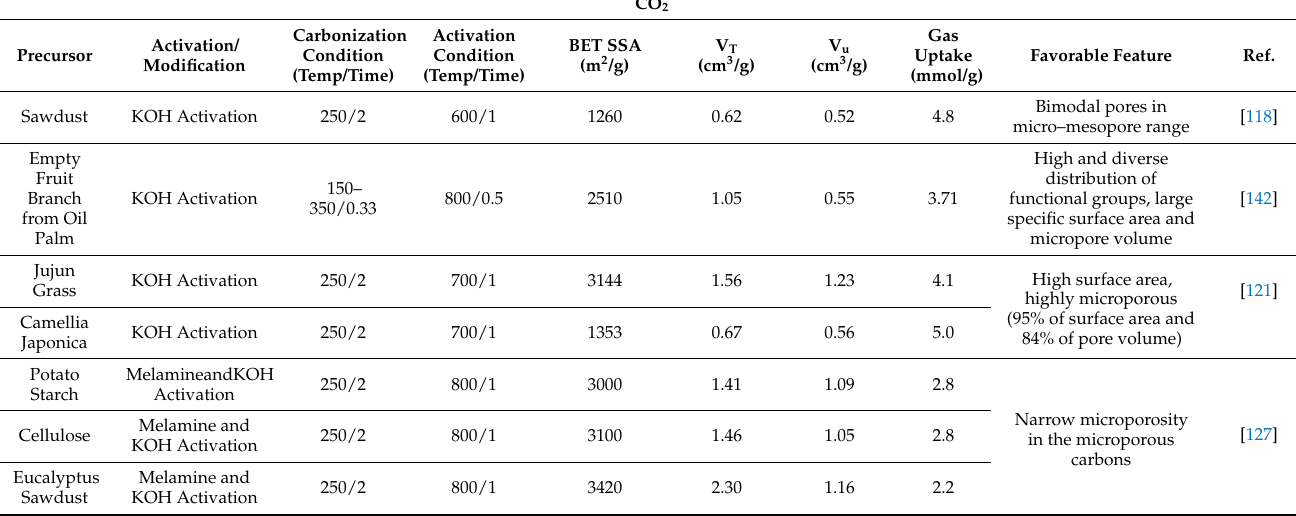
Table 5. Greenhouse gas adsorption by